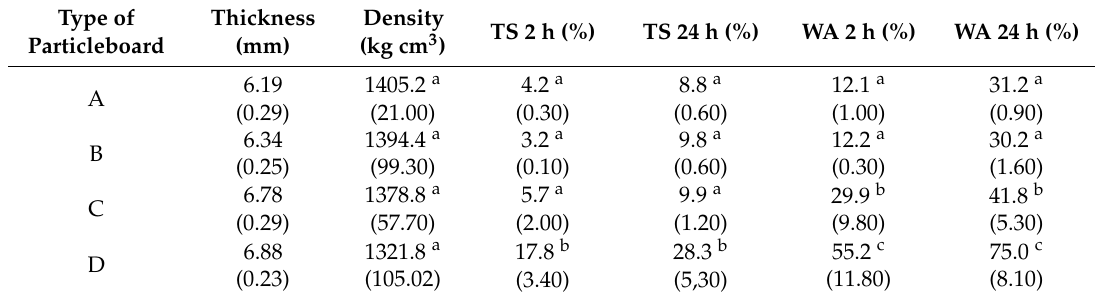
Table 3. Physical properties after 28 days of curing.